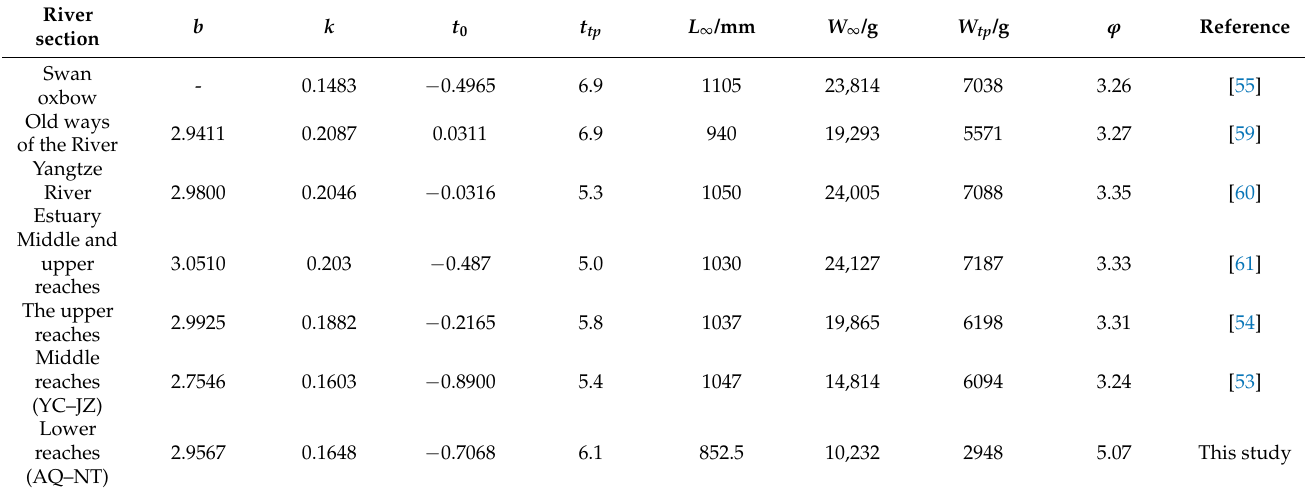
Table 7. Growth parameters of different populations of Silver